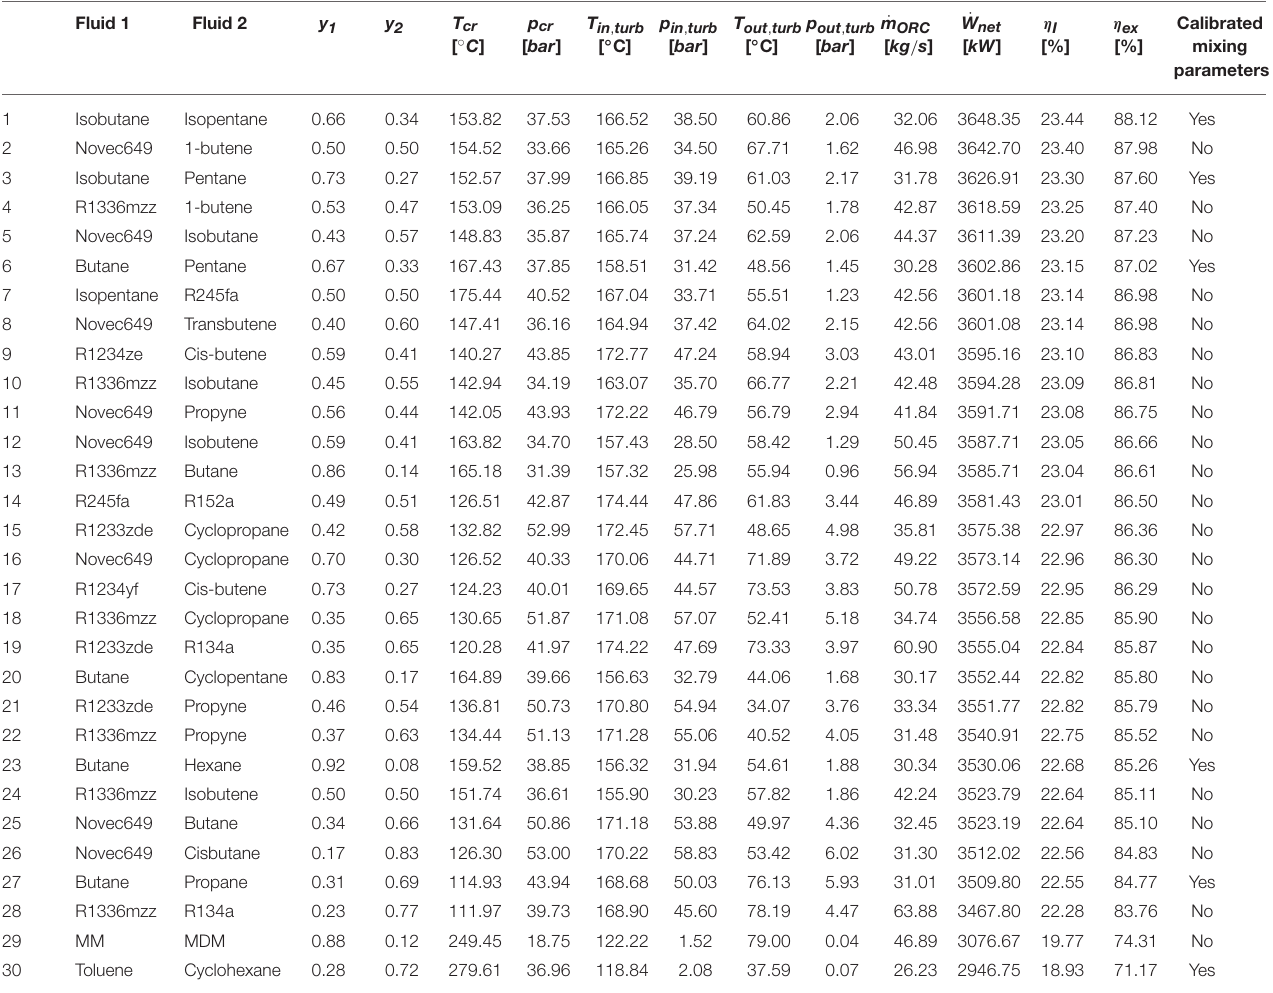
TABLE A2 | Thermodynamic optimization results of all mixtures ranked according to the exergy efficiency. Fluid